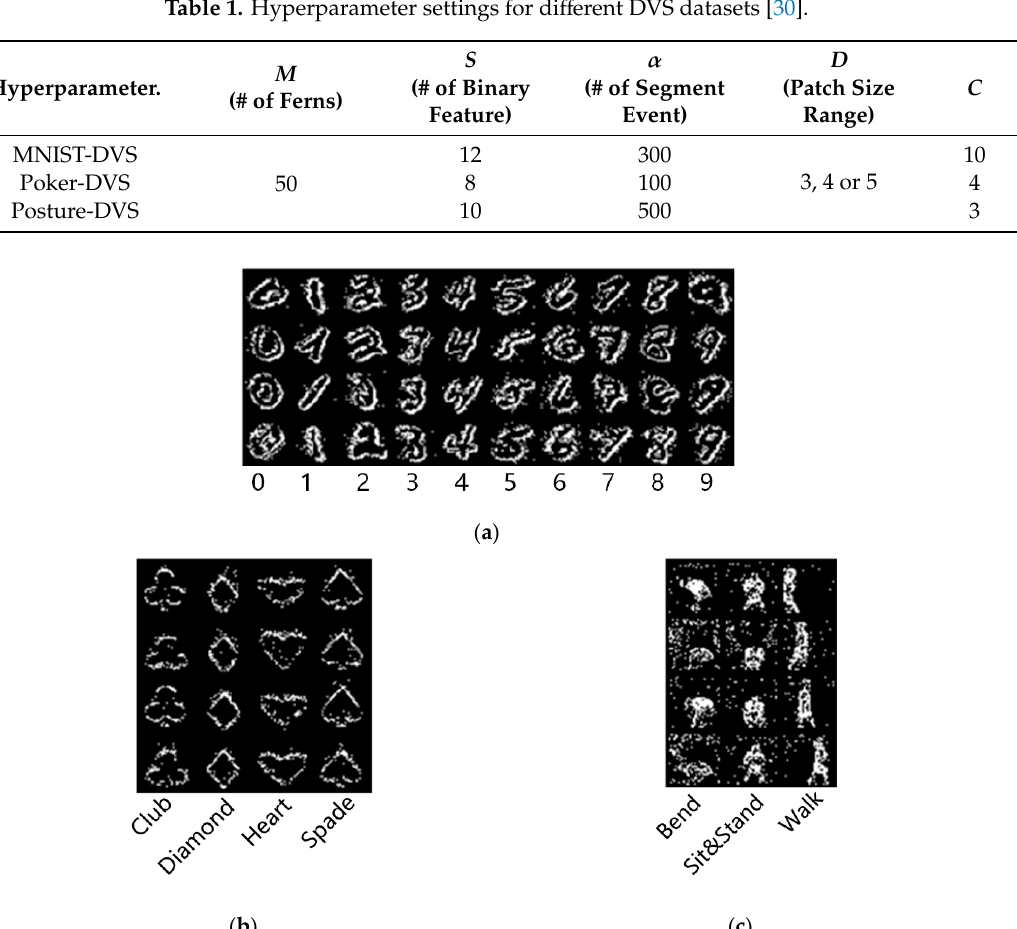
Figure 7. Some pseudo-images constructed from address-event representation (AER) segments of three dynamic vision sensor (DVS) datasets. ( a ) MNIST-DVS dataset with C = 10 classes. ( b ) Poker-DVS dataset with C = 4 classes. ( c ) Posture-DVS dataset with C = 3 classes. Table 2. Resource and power consumptions of our FPGA prototype for di ff erent DVS datasets. FPGA